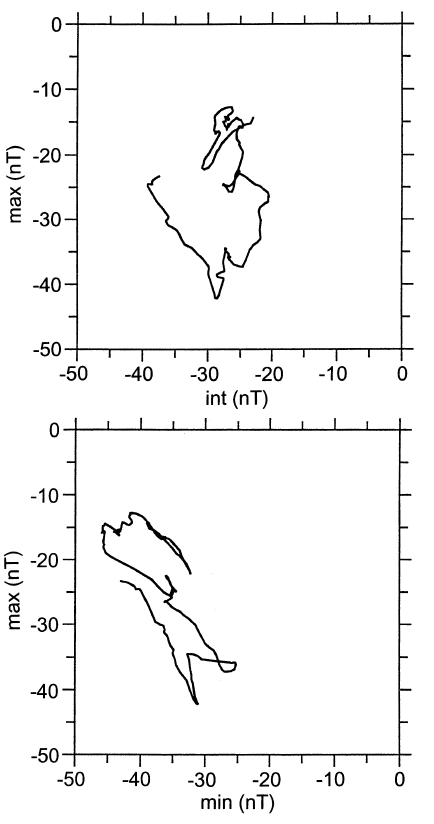
Fig. 4. Hodogram of the time variations of the magnetic-field components in principal-axis-analysis coordinates for the temporal variations during the hours 30 to 34. Top : maximum and intermediate variance components; bottom : maximum and minimum variance components. Note the indications for a field rotation, interpreted as a trait of a magnetic flux rope